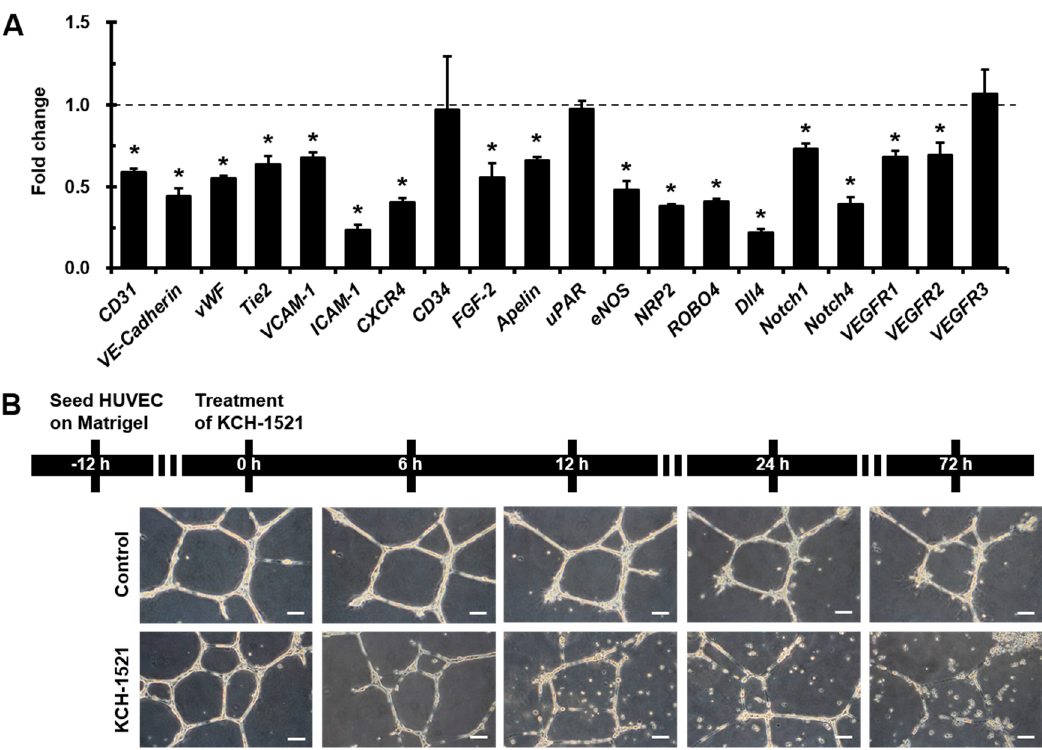
Figure 3. In vitro anti-angiogenic effects of KCH-1521 on HUVECs. ( A ) Relative changes in angiogenic gene ( CD31 , VE-Cadherin , vWF , Tie2 , VCAM-1 , ICAM-1 , CXCR4 , CD34 , FGF-2 , Apelin , uPAR , eNOS , NRP2 , ROBO4 , Dll4 , Notch1 , Notch4 , VEGFR1 , VEGFR2 , and VEGFR3 ) expression in KCH-1521-treated cells compared to the control, as determined by real-time PCR. The dotted line represents the relative value of the control; ( B ) schematic diagram and representative phase-contrast images of in vitro tube forming assay of the control and KCH-1521-treated cells on Matrigel. Scale bars = 100 μ m. Data shown represent the mean ± SD of three independent experiments (* p < 0.05).